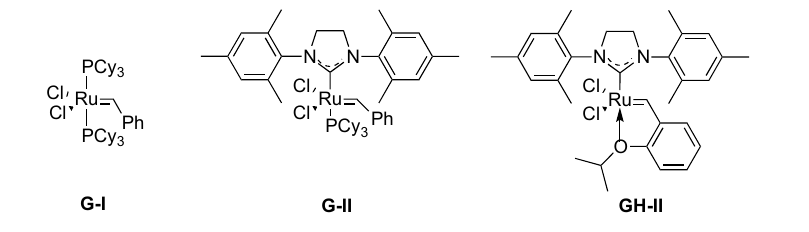
Figure 1. Catalysts for olefin metathesis.